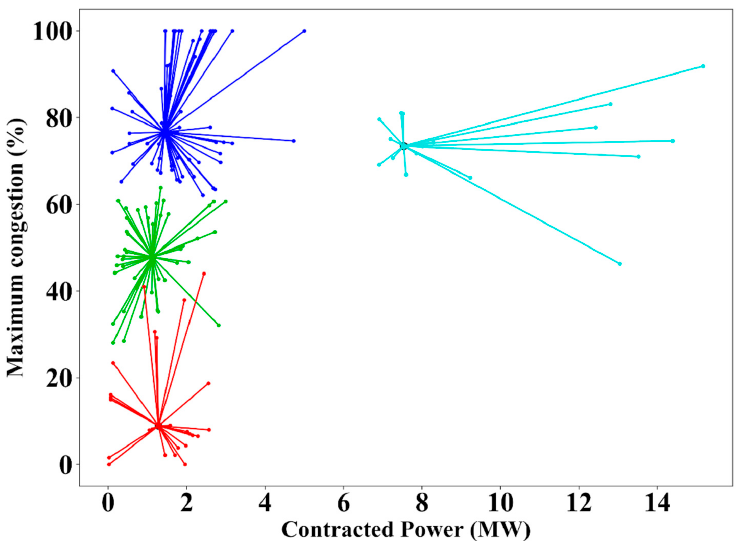
Figure 8. Maximum congestion in relation to the total contracted power in the case study.